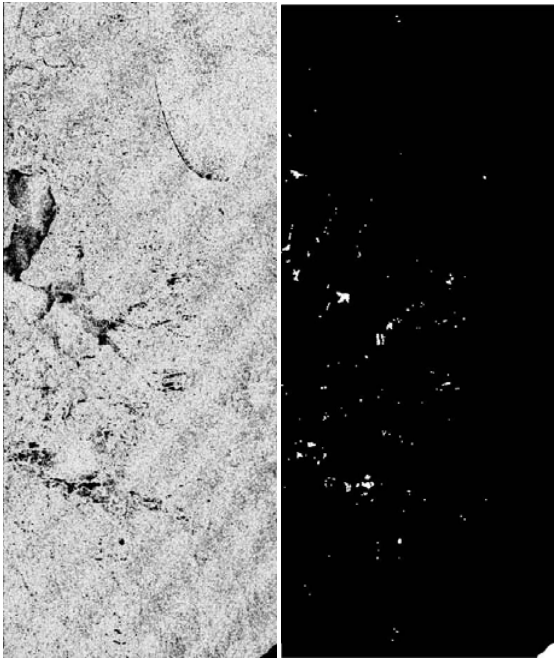
Figure 8. difference map after PCA analysis and final change detection